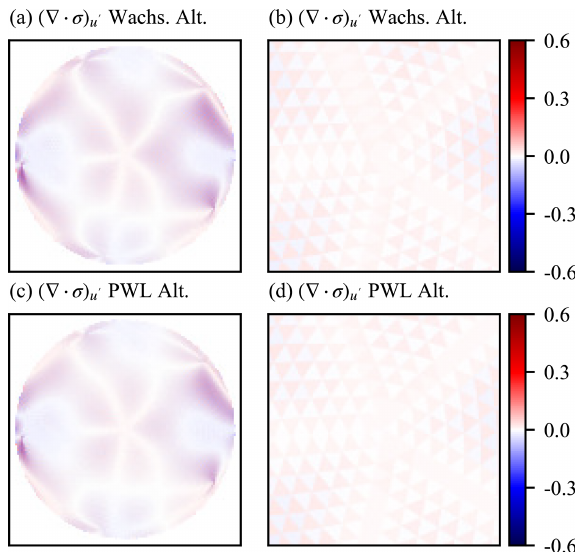
Figure 10. Orthographic projection of one hemisphere of the stress divergence operator error for the unit sphere test case. Shown are re- sults for the variational schemes using the alternate area denomina- tor formulation. Panels (a) and (b) show results for the Wachspress variational scheme, while (c) and (d) show results for the PWL vari- ational scheme. Detail is shown around one of the pentagonal mesh cells for each scheme in (b) , (d) .